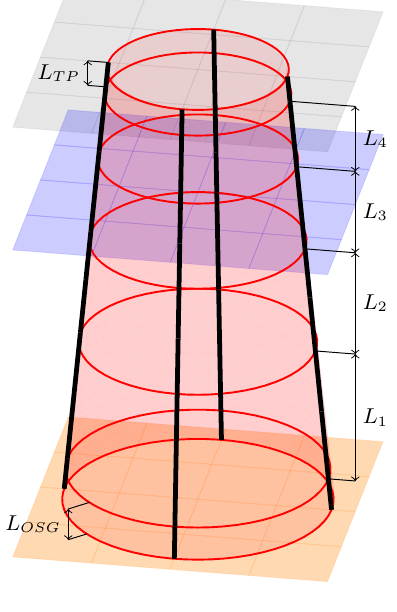
Figure 2. Creation of the jacket topology in four steps.